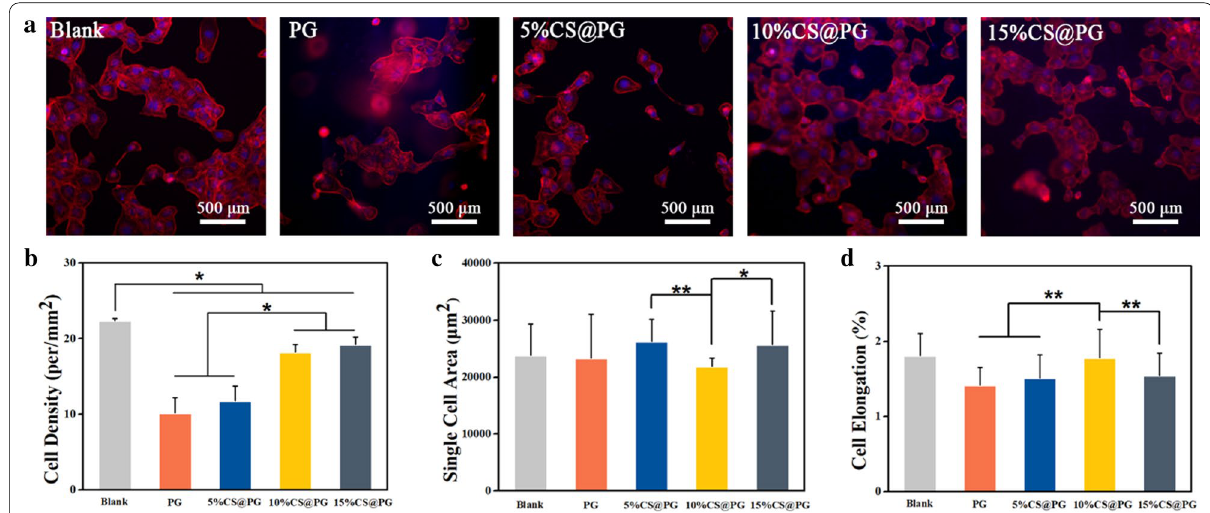
Fig. 8 a Cell adhesive morphology of HAECs on the CS@PG scaffolds (DAPI: cell nuclei; Rhodamine-Phalloidin: cytoskeleton). b Cell density. c Single cell area, d Cell elongation in different groups of